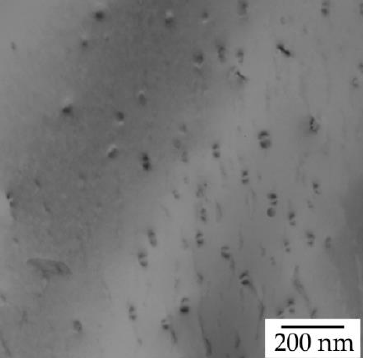
Figure 4. TEM image of the AlMnYbZr AC alloy in the initial state — see secondary Al 3 (Yb,Zr) par- ticles in coffee bean contrast. Table 1. Initial values of microhardness HV0.1 for the AlYb and AlMnYbZr as-cast (AC) and cold rolled alloys with reduction of 40% (CR40) and 70% (CR70).